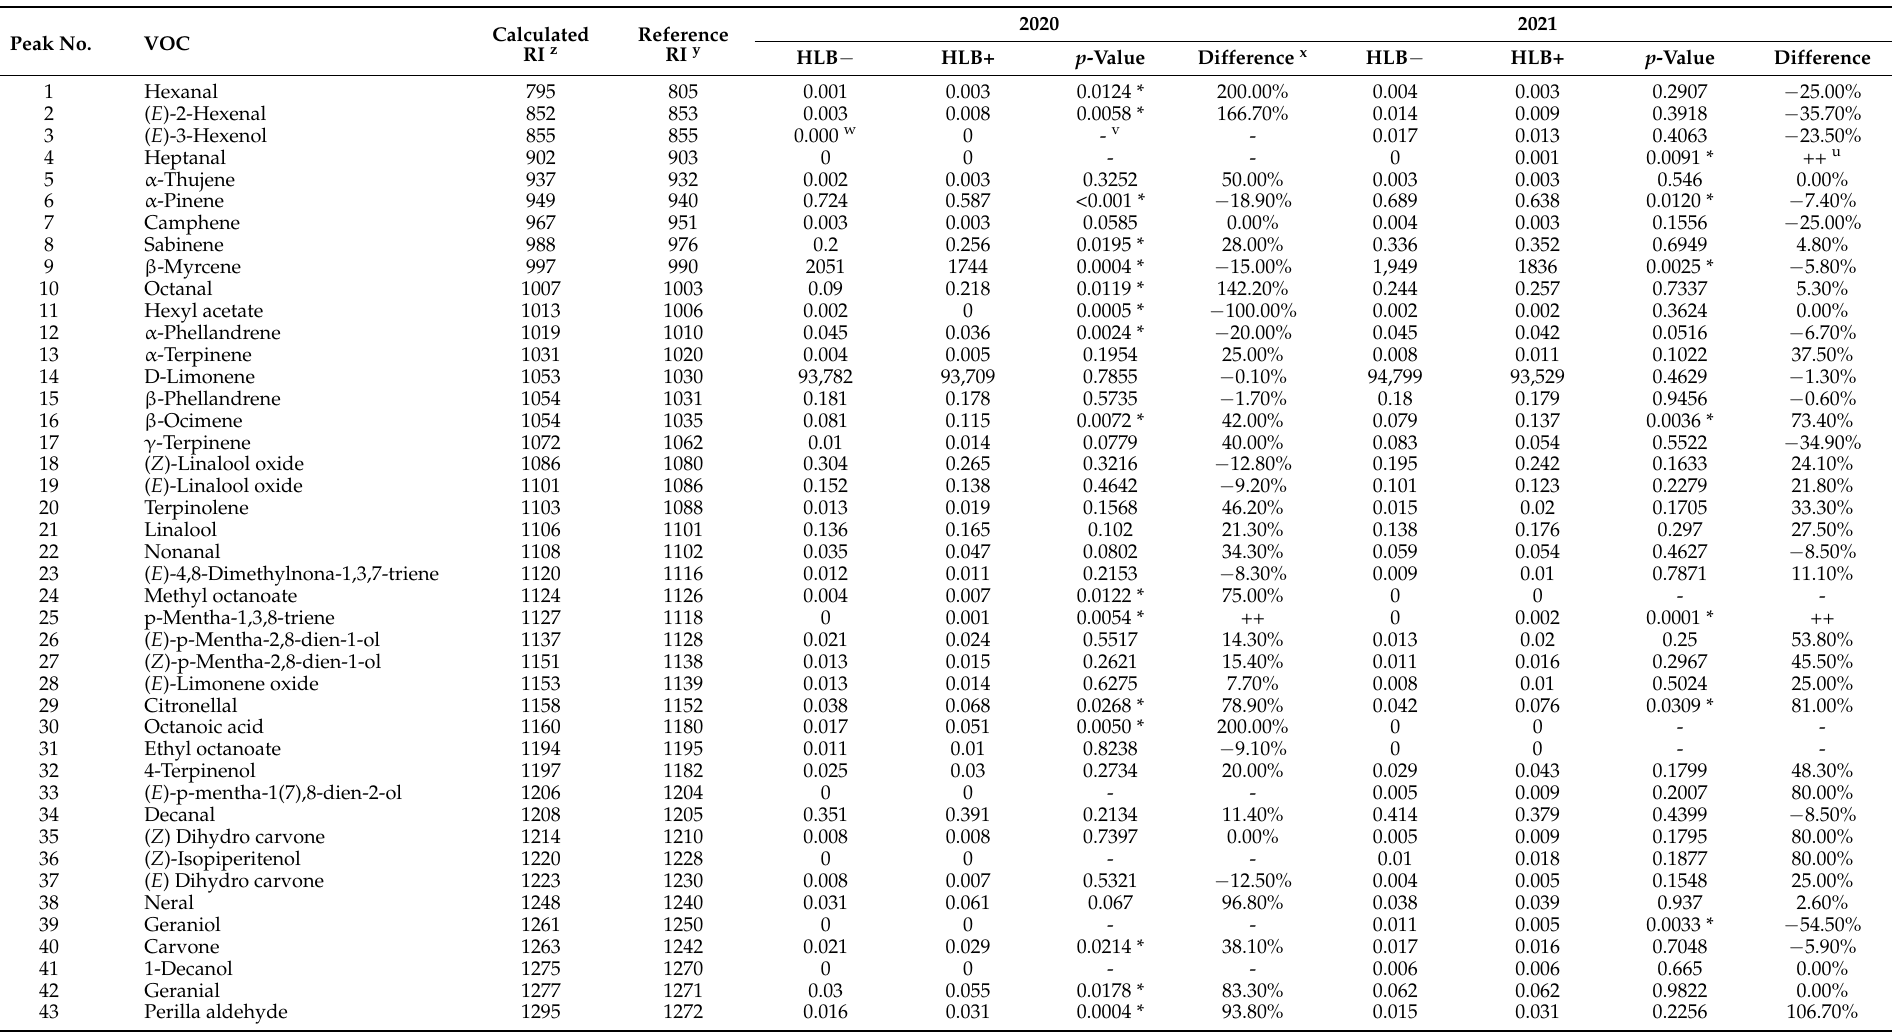
Table 2. Chemical composition (%) of the peel oil of ‘Ray Ruby’ grapefruit of healthy (HLB − ) and HLB-affected (HLB+) fruits from 2020 and 2021 harvests. Peak